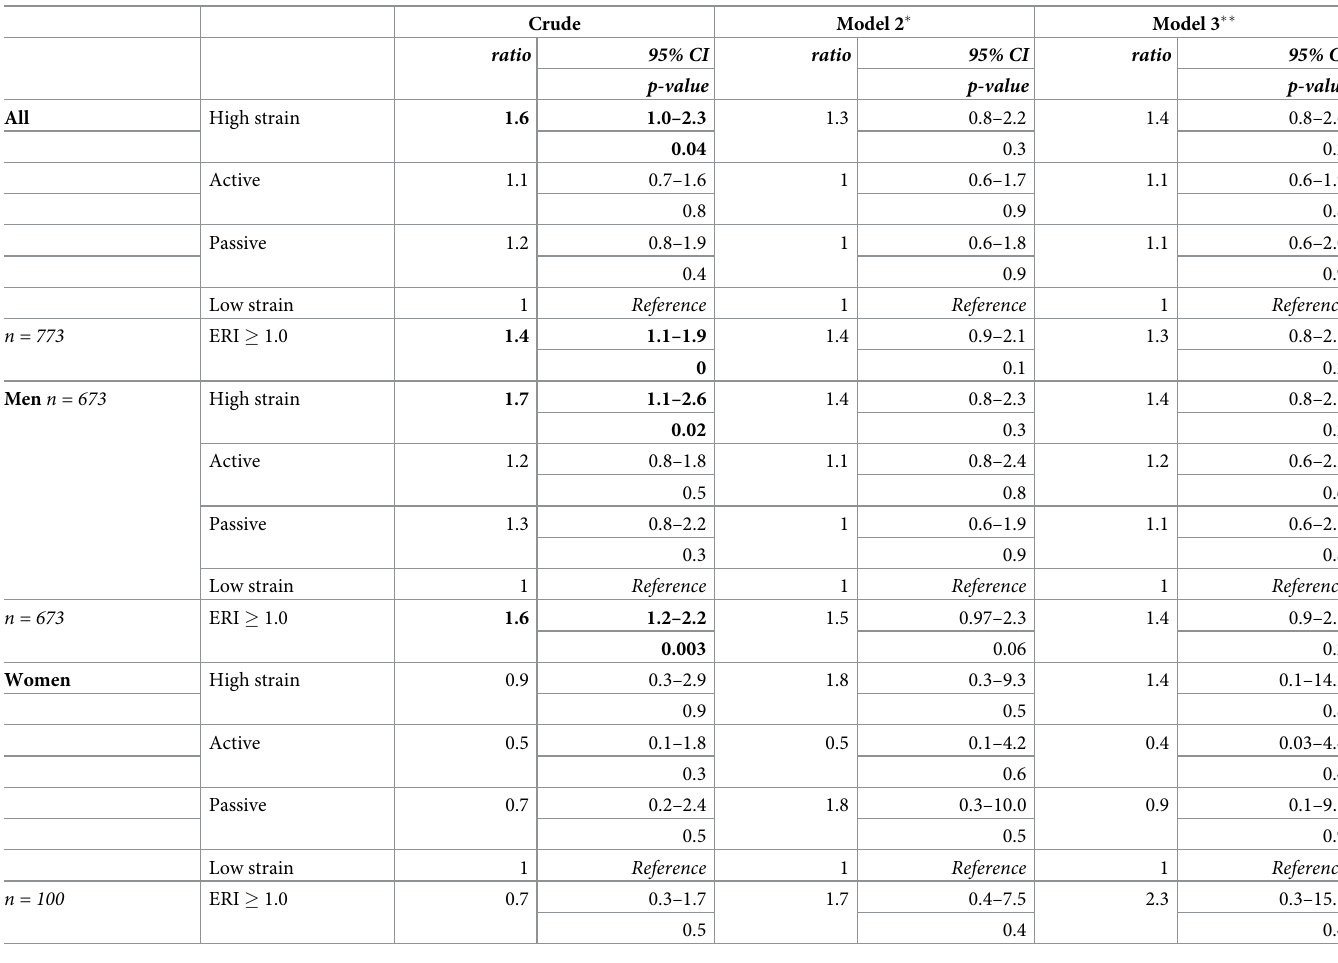
Table 4. Regression analyses of psychosocial conditions between cases with extended work � 63 years and controls who retired � 62 years in white-collar